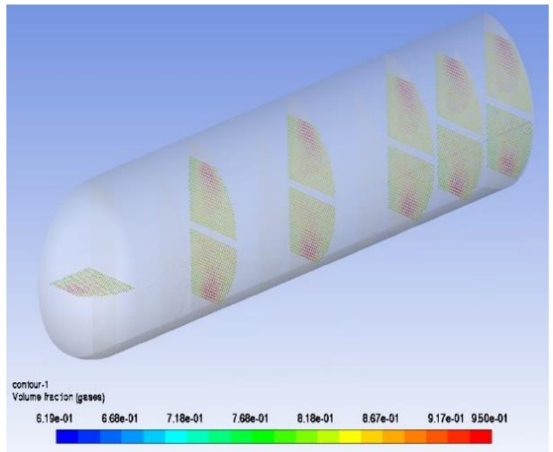
Figure 13. Distribution law of gas volume fraction along pipe.